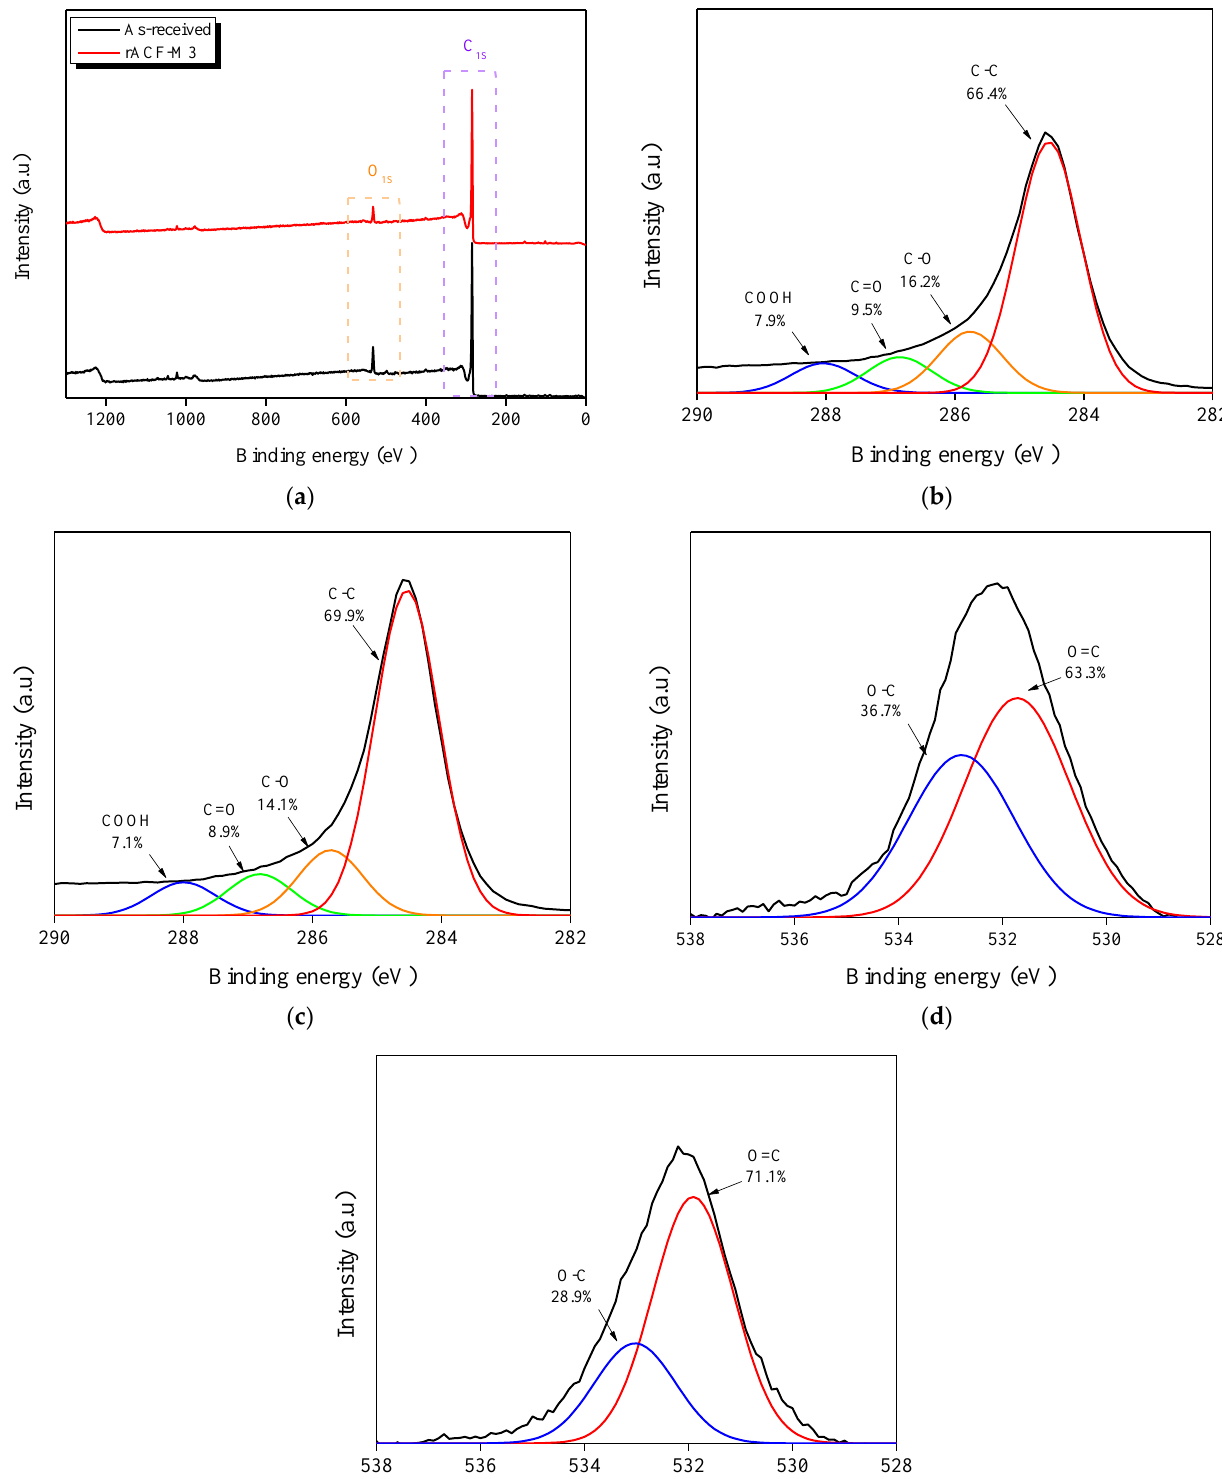
Figure 3. X-ray photoelectron spectroscopy survey spectra ( a ); high-resolution C 1S spectra of As- received ( b ) and rACF-M3 ( c ); high-resolution O 1S spectra of As-received ( d ) and rACF-M3 ( e ).